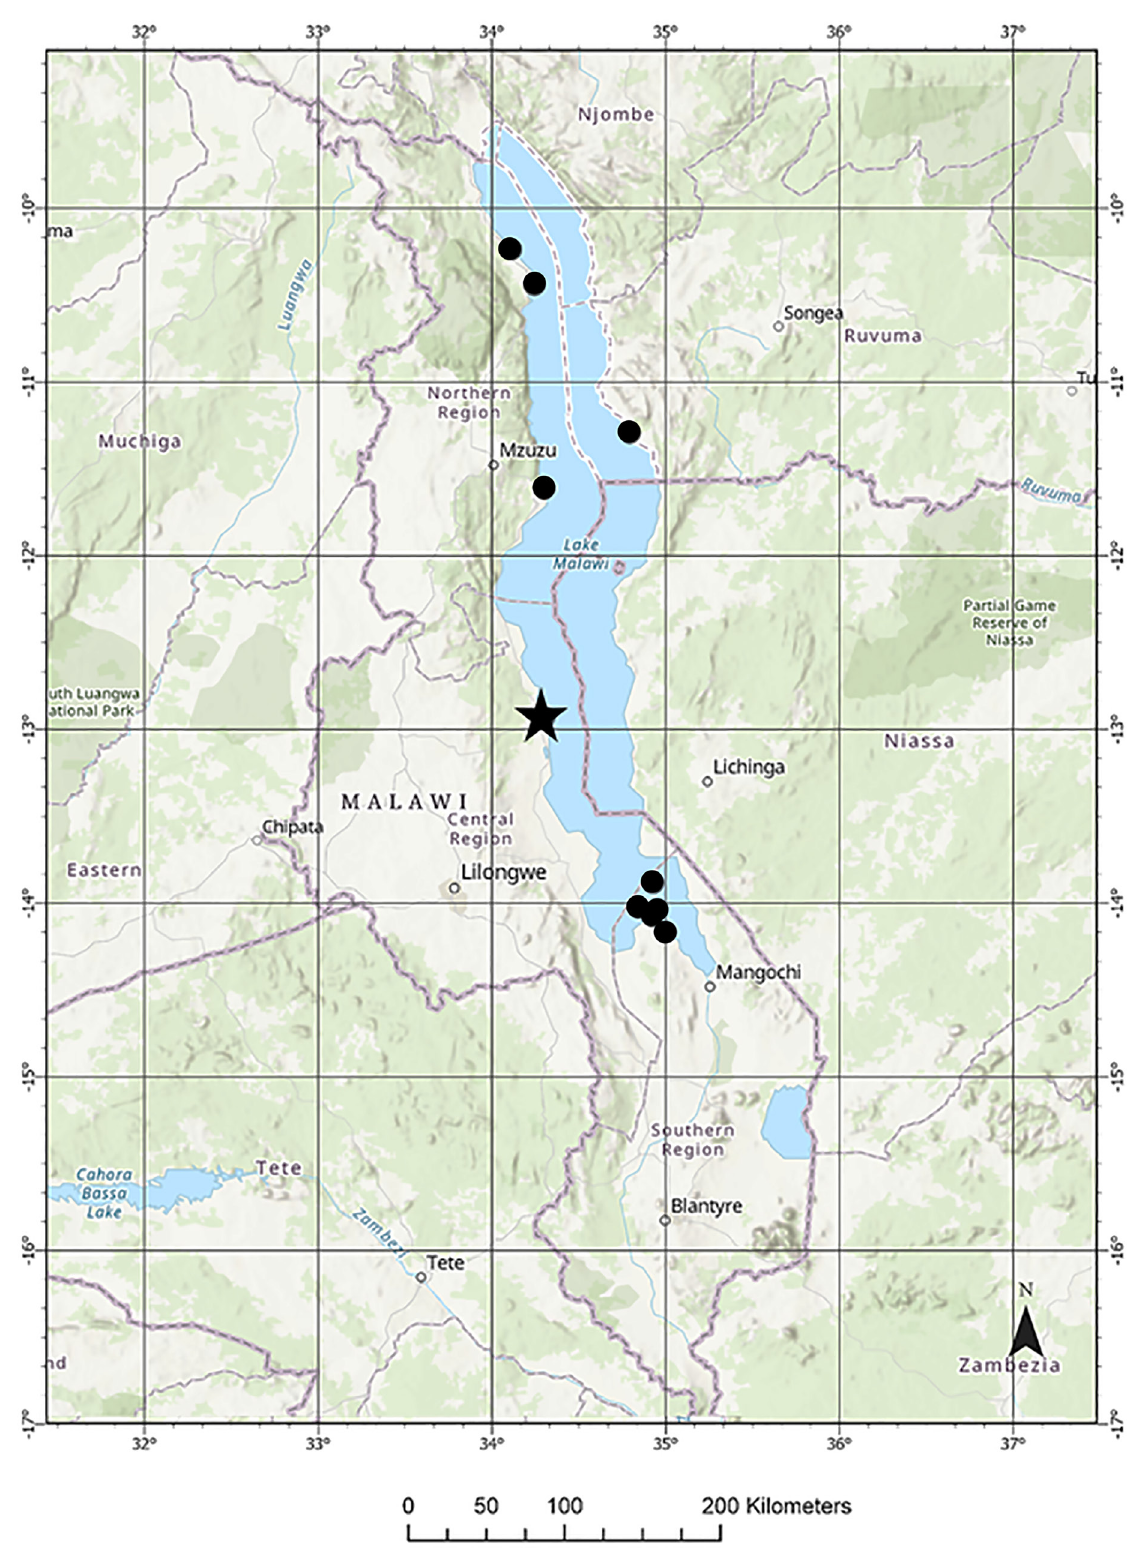
Fig. 2. Map showing the updated geographic distribution of Potamonautes orbitospinus (Cunnington, 1907). The black star shows the type locality. See text and Table 2 for exact